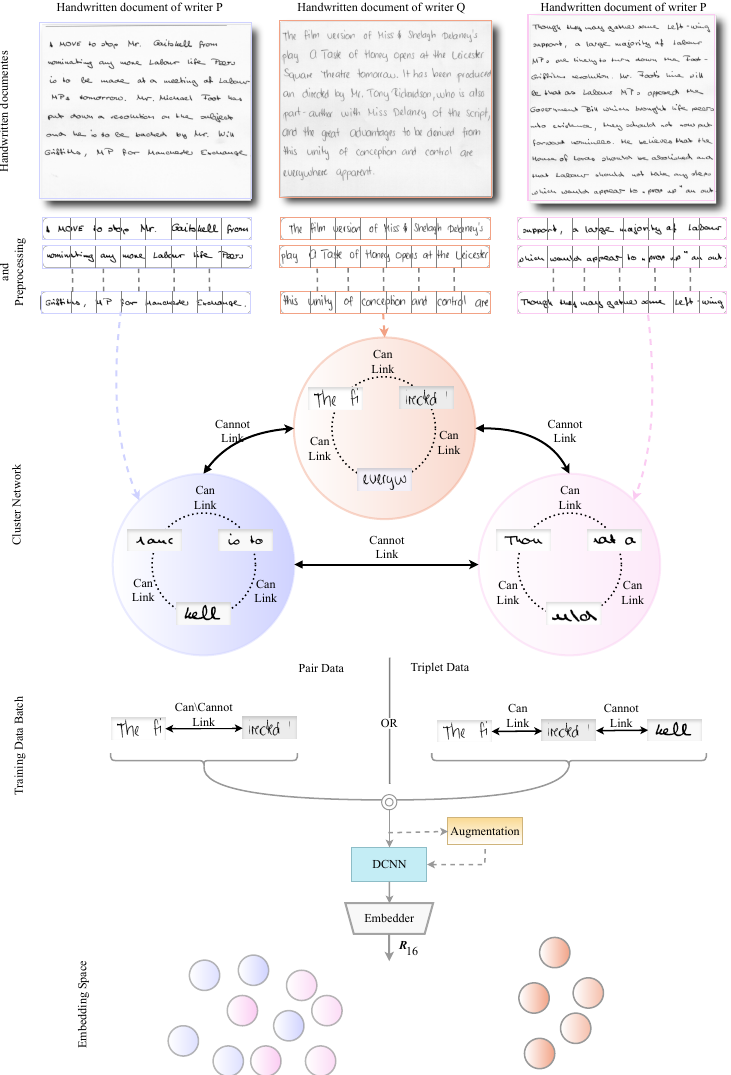
Figure 2. Overall procedure of Self-Writer. First, each manuscript is segmented into lines and assigned a pseudo label for each script. Additionally, an OpenCV-based Python script is used to preprocess the line images. Furthermore, a cluster network is constructed from the manuscript’s line segments, using a nonoverlapping sliding window approach to generate smaller text blocks. Finally, depending on the requirements of the Siamese network, the cluster network is used to construct training data batches. The pairwise architecture receives two input data; either a can-link pair or a cannot-link pair. However, it demands an equal number of can-link and cannot-link pairs in a batch of training data. On the other hand, triplet architecture receives three input data; a pair of can-link data and cannot-link data, and then the DL architecture or the embedder is trained on randomly augmented training